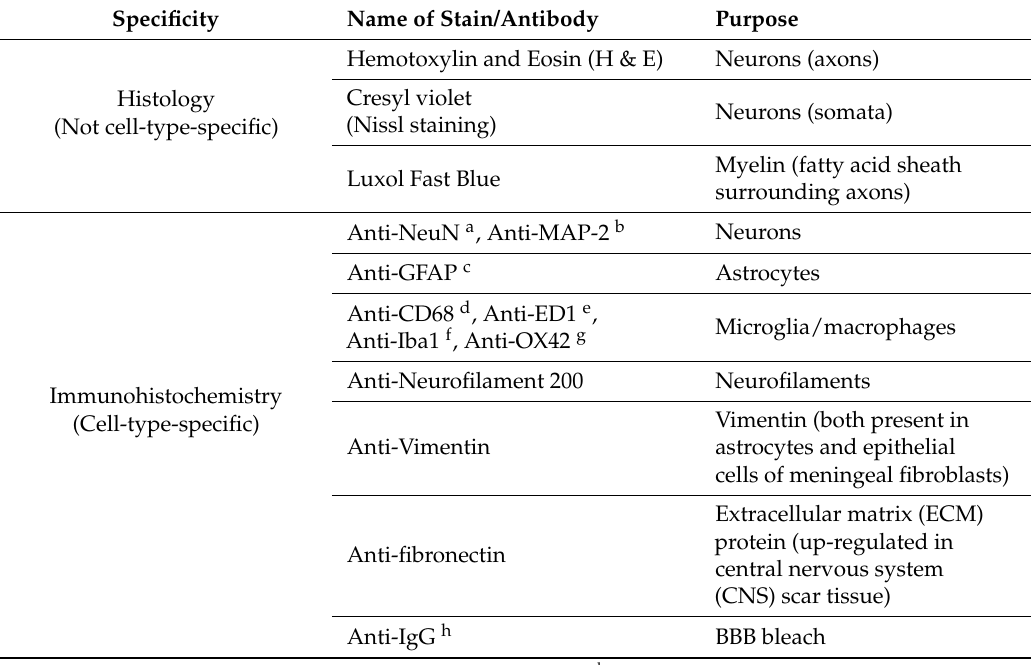
Table 2. Examples of common stains and antibodies used to observe brain slices